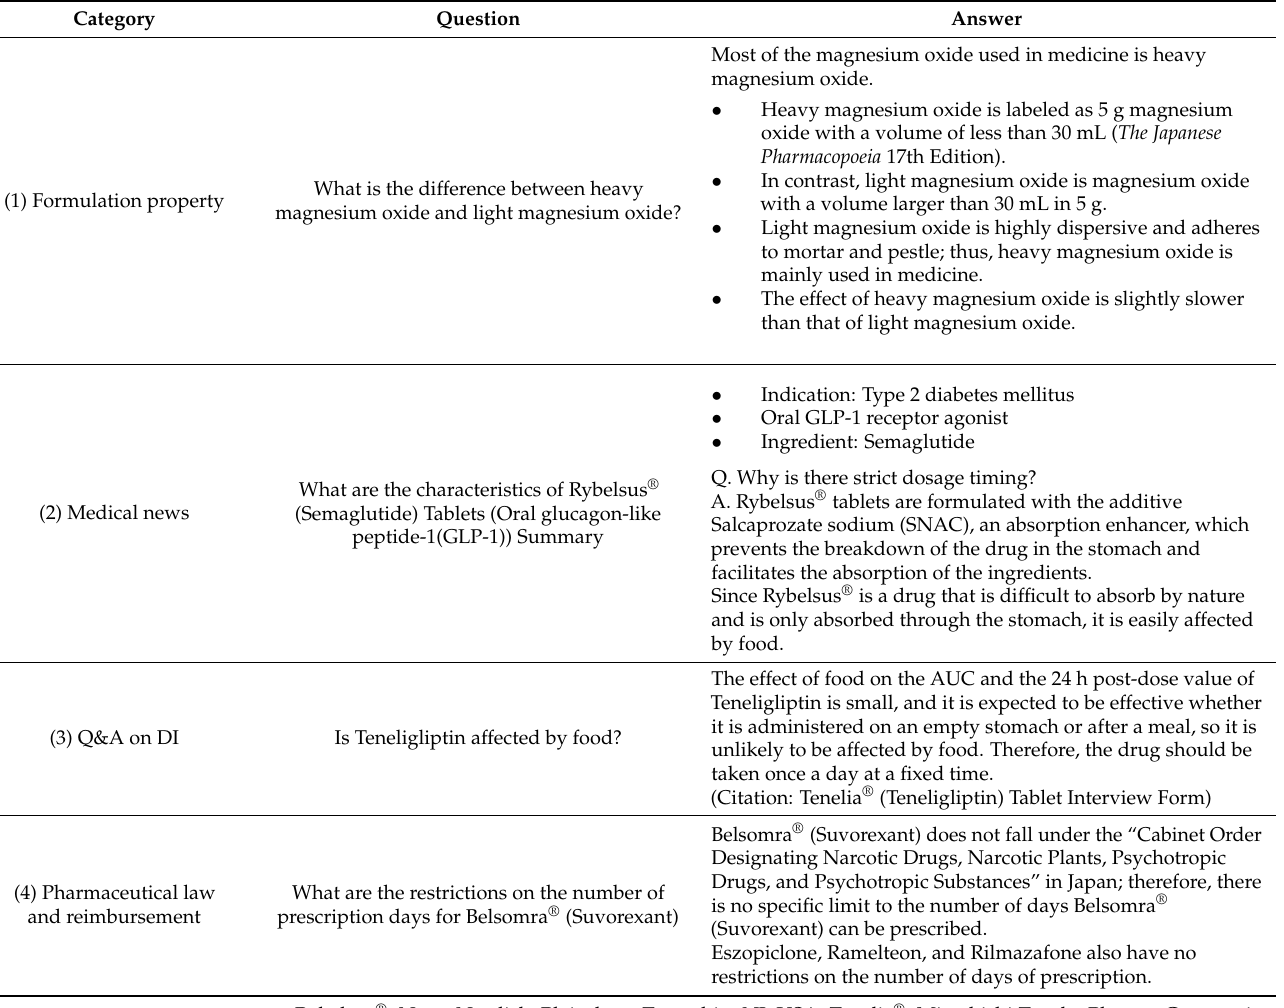
Table 1. Examples of the website